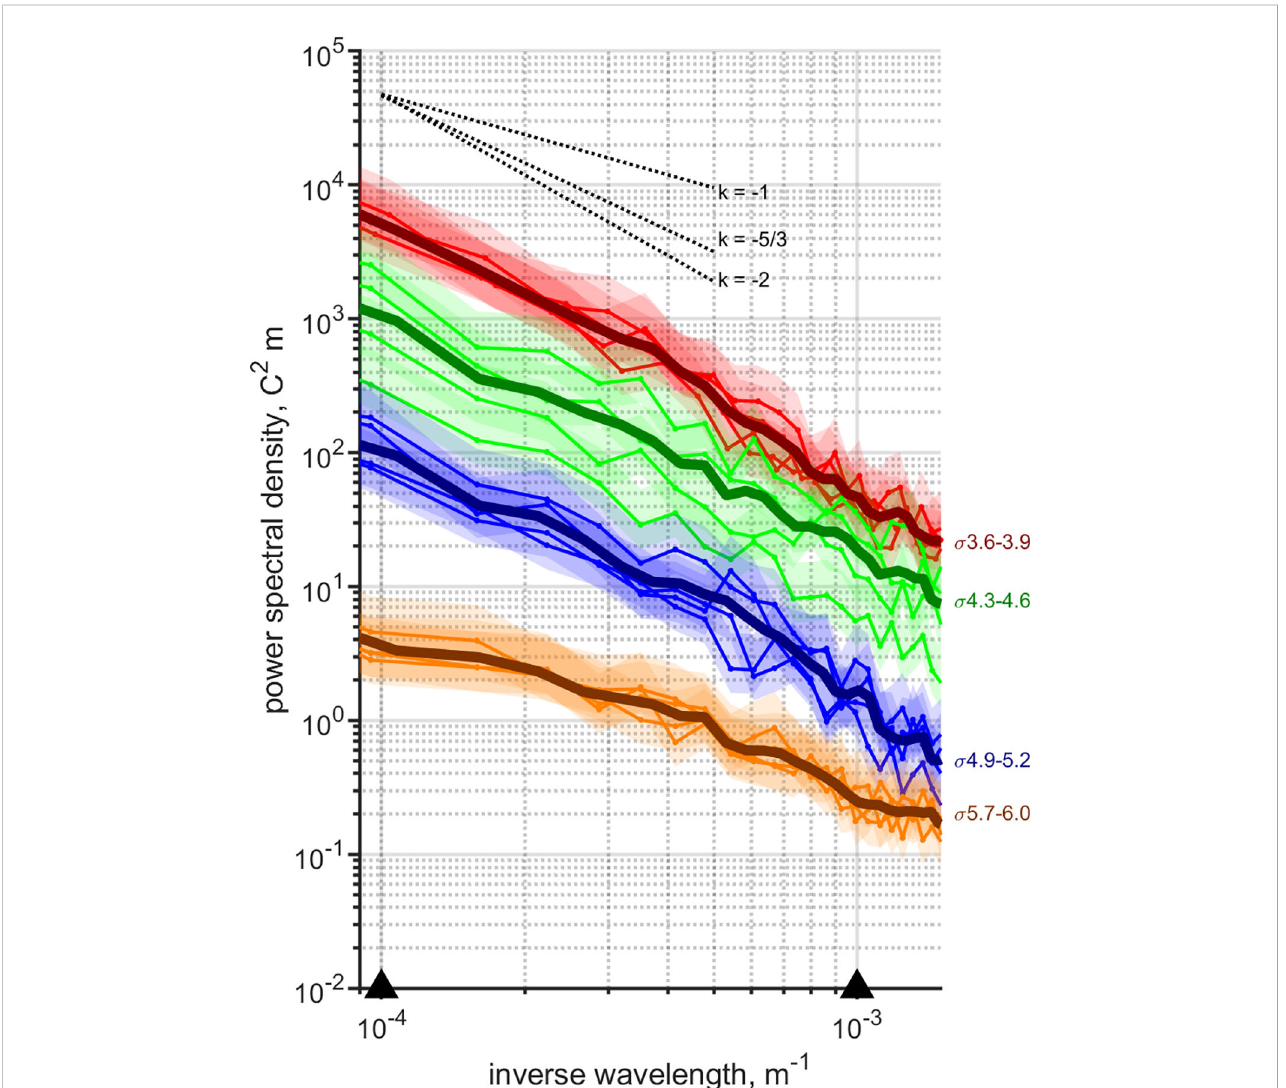
FIGURE 8 The wavenumber spectrum of isopycnal temperature of glider mission in May – June 2018. Thin lines present spectra along individual isopycnal surfaces (with a step of 0.1 kg m -3 ) in the density ranges of 3.6 – 3.9 (red), 4.3 – 4.6 (green), 4.9 – 5.2 (blue), and 5.7 – 6.0 (orange) kg m -3 with the shadowing showing the 95% con fi dence limits. Thick lines demonstrate the averages of the individual spectra. Black dotted lines show the slopes of -1, -5/3, and -2. From left to right, the black triangles are located at wavenumbers corresponding to 10 km and 1